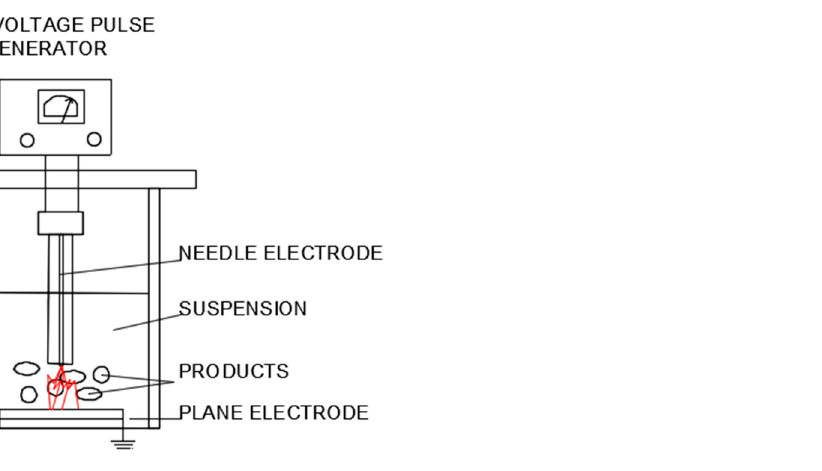
Figure 5. Draw of batch High Voltage Electrical Discharge (HVED) extraction device.